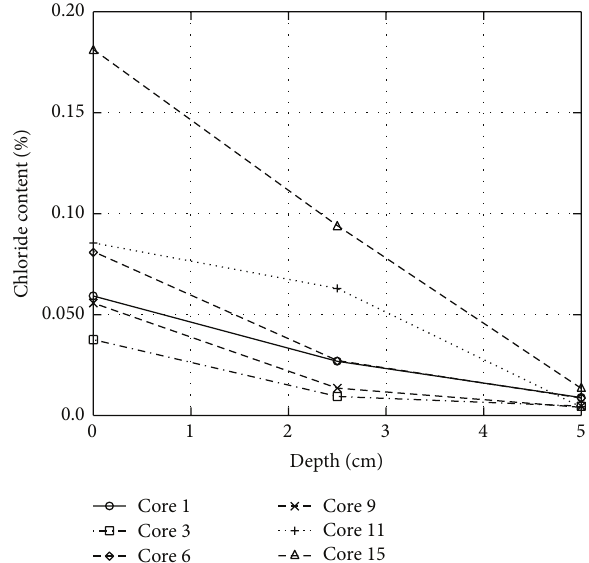
Figure 19: Chloride content at different depths.